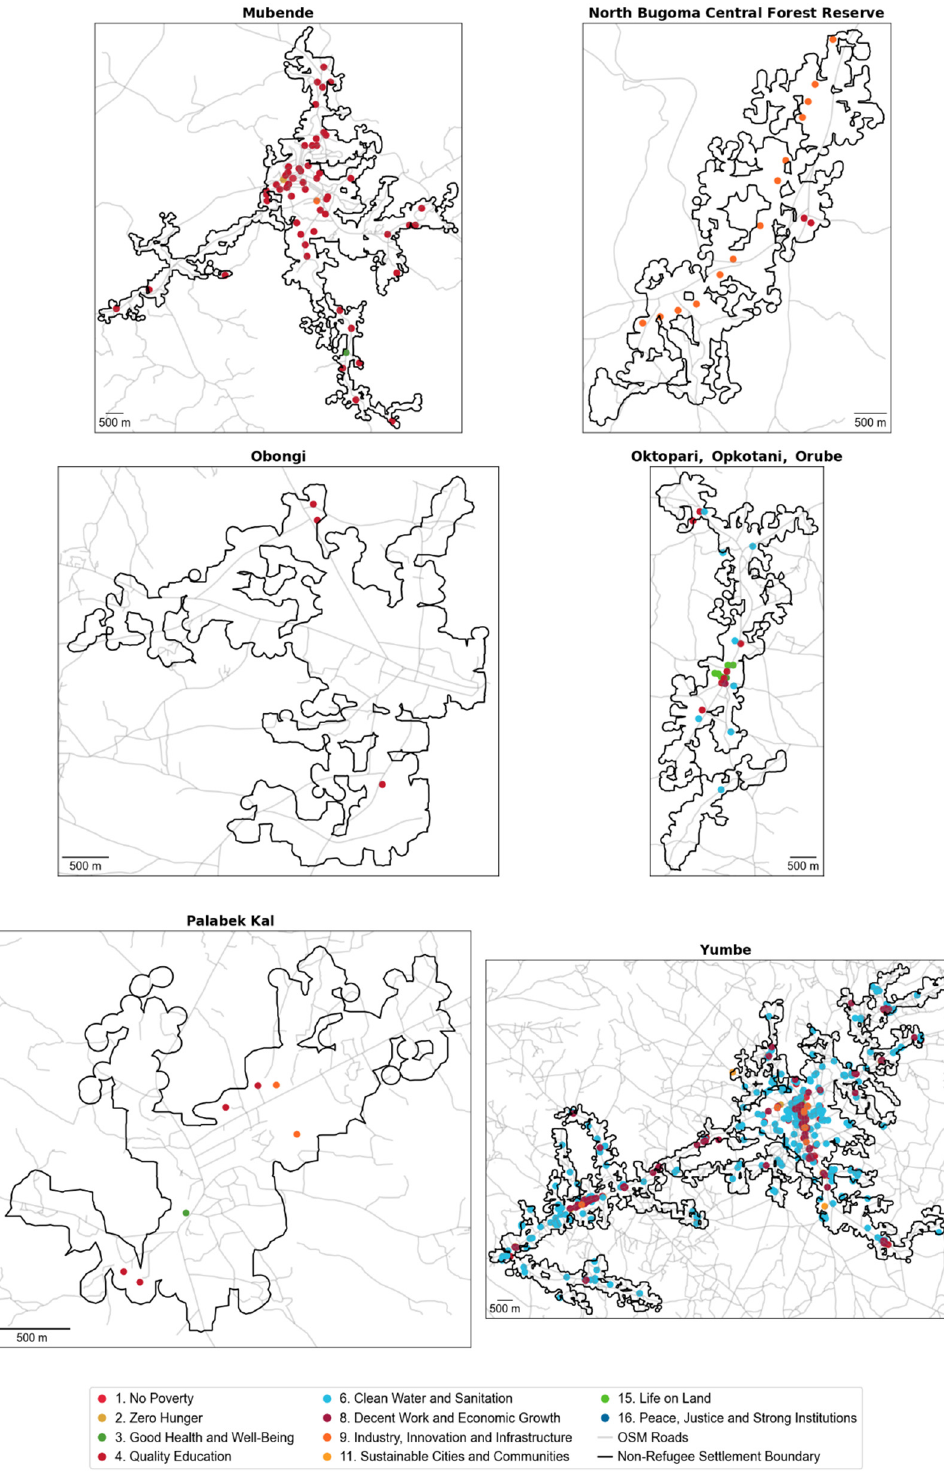
Figure A2. Maps of SDG-relevant OSM feature distribution, OSM roads, and building footprints and settlement boundaries across 26 non-refugee settlements. Note the differing cartographic scale between settlement maps.